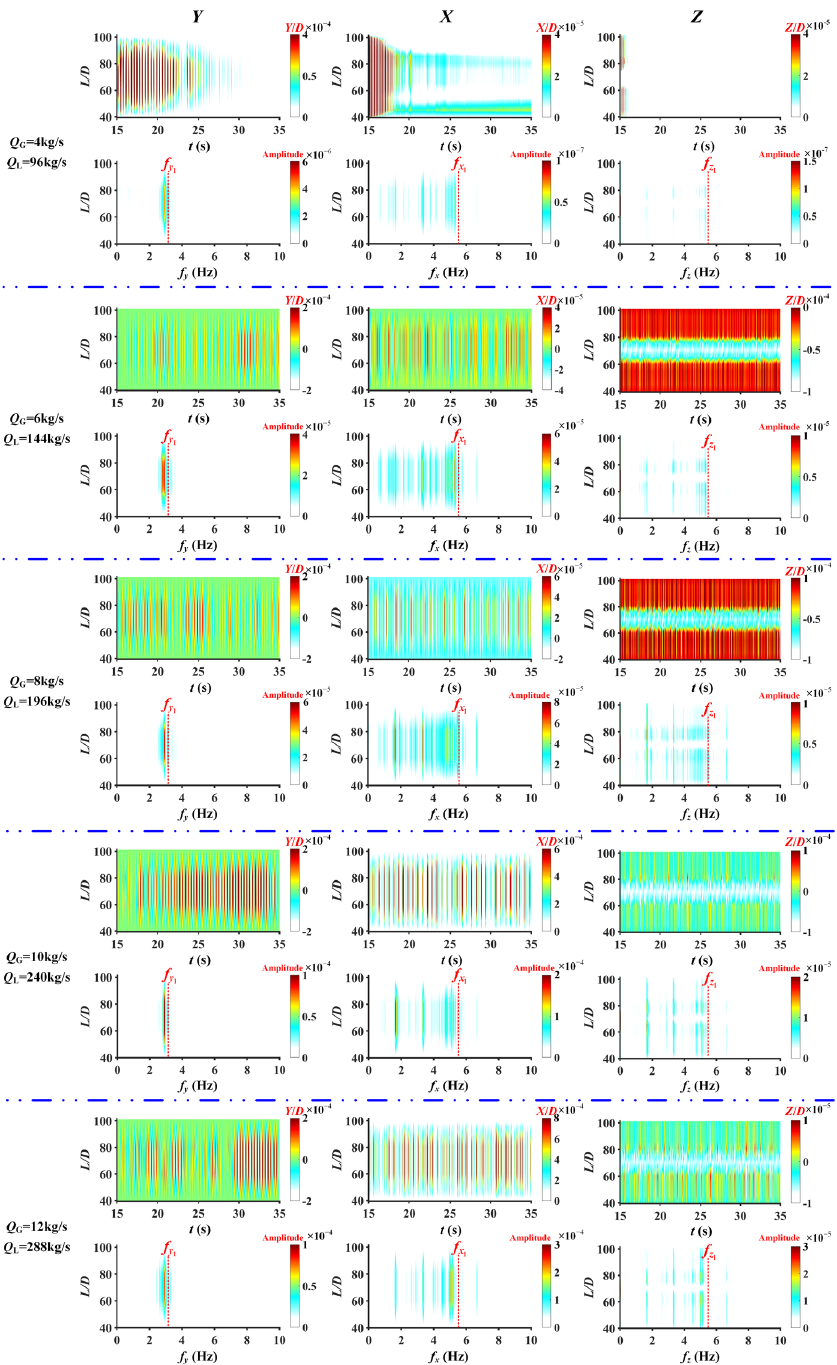
Figure 18. The temporal–spatial evolution of response displacements and the associated spatial variation of response frequencies at different inlet mass flow rates.